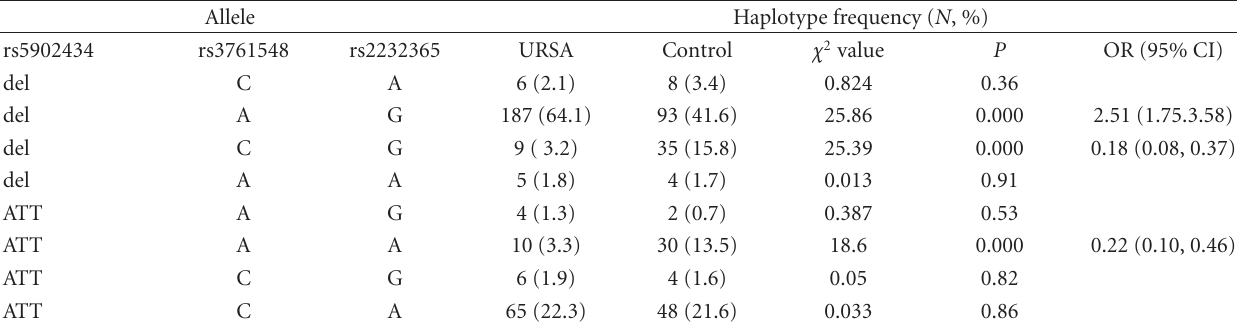
Table 3: Eight three-locus Foxp3 promoter region haplotypes identified in URSA group and the control group and their estimated frequencies using the software HAPLOVIEW (version